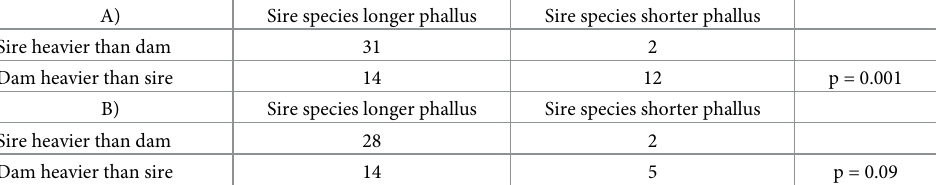
Table 2. Summary of the relative importance of phallus and mass asymmetries being complementary or not, derived from the data in S2 Table in S1 File. A) Data for all 59 F 1 hybrids with large phallus asymmetries. B) Data for the same set of hybrids, but with the Mareca americana hybrids with Anas platyrhynchos and A . acuta removed because they failed to support the phallus asymmetry